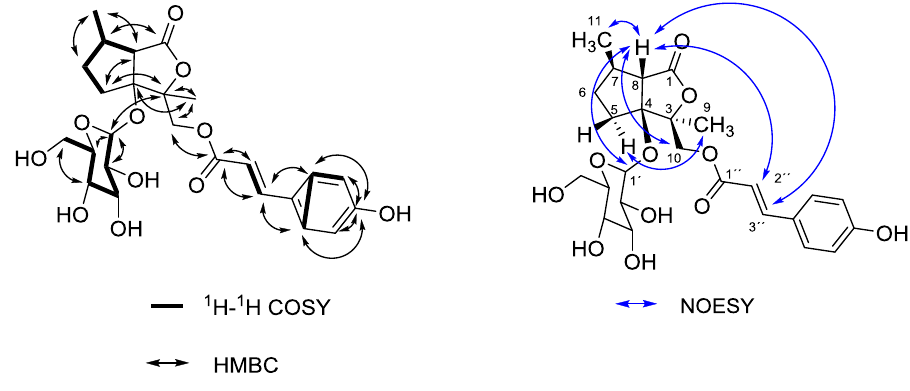
Figure 3. Key 1 H- 1 H-COSY, HMBC and NOESY correlations of 4